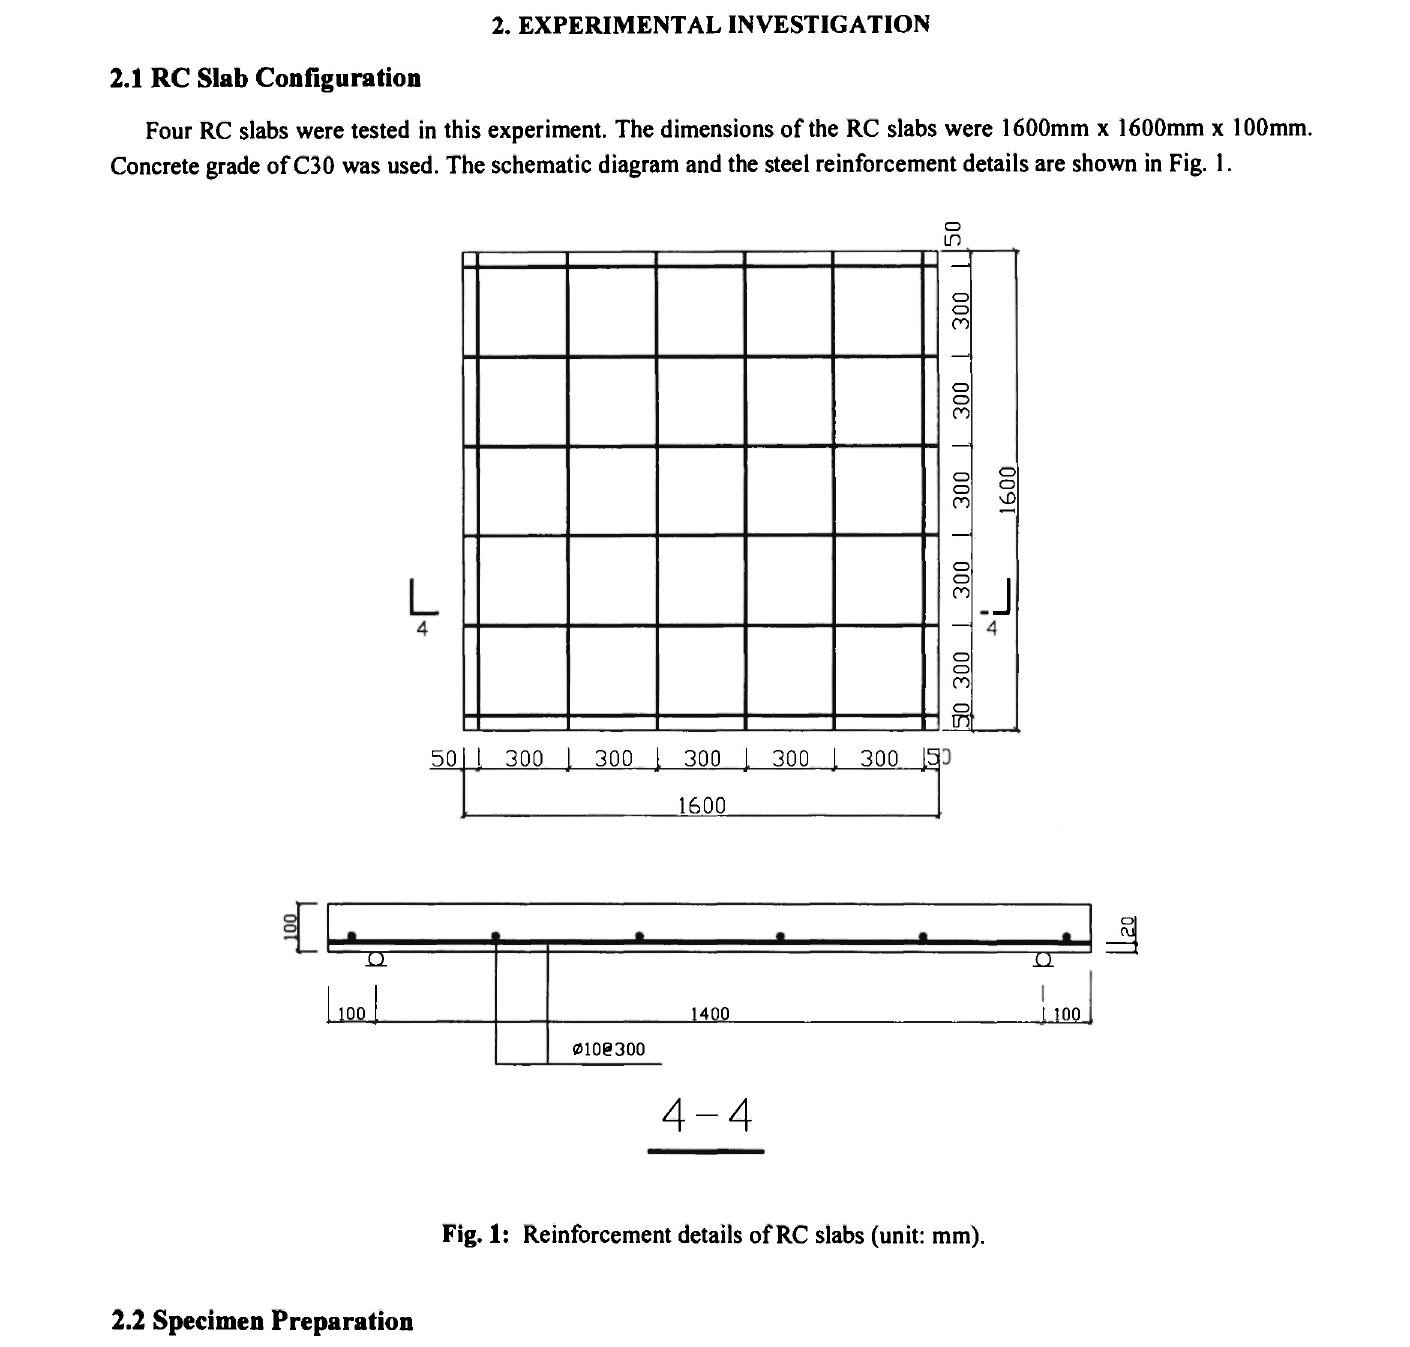
Fig. 1: Reinforcement details of RC slabs (unit: